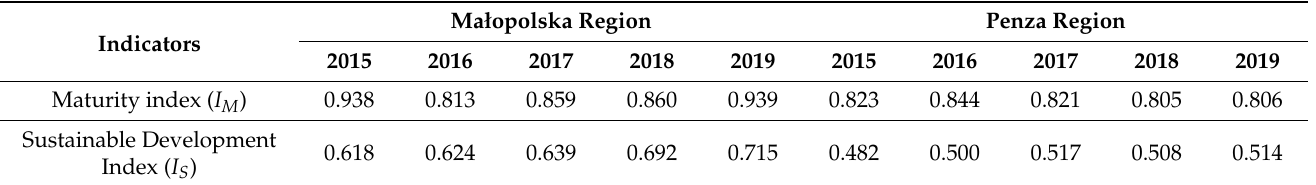
Table 7. Interconnection between the maturity of regional entrepreneurial ecosystem and sustainable development of the region.